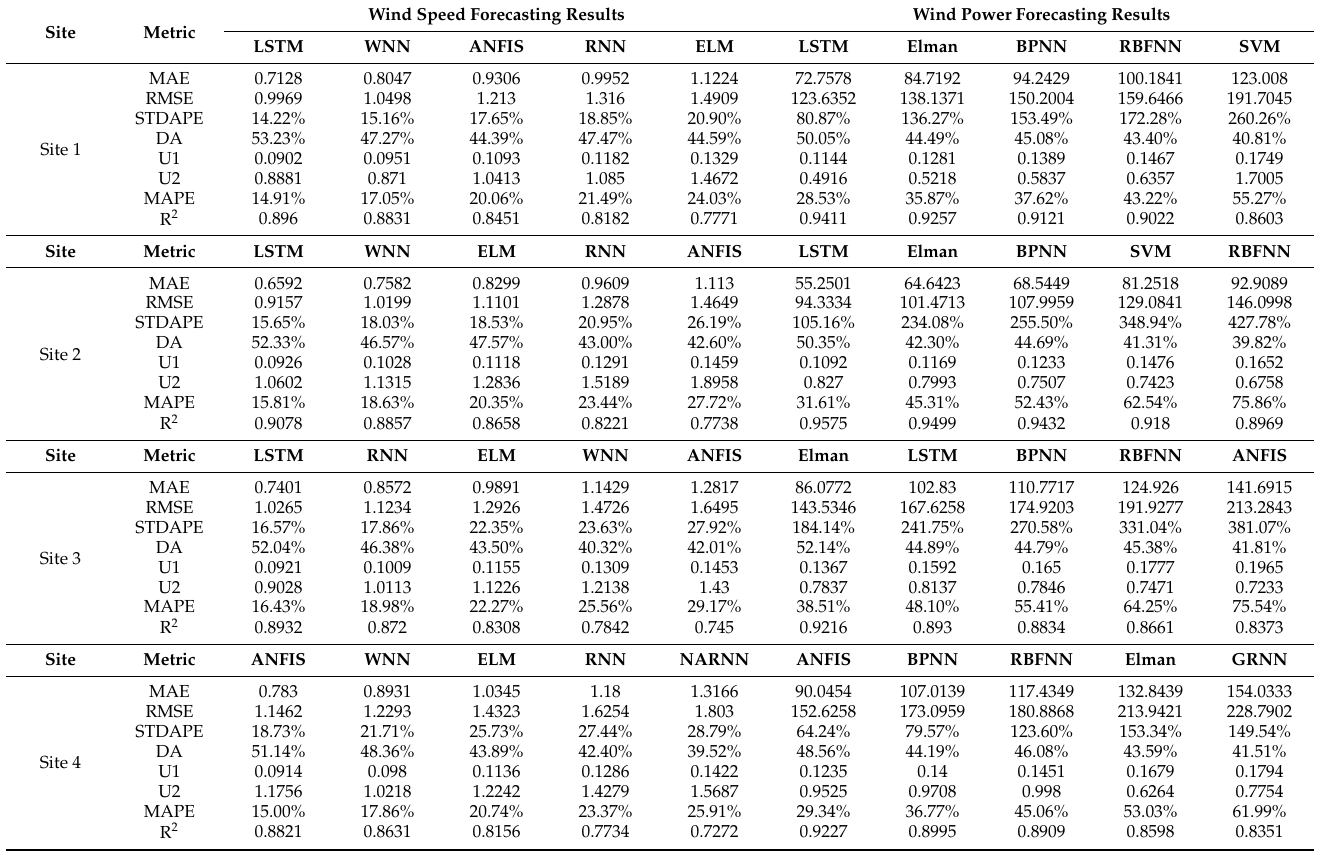
Table A1. The forecasting performance of five optimal sub-models for wind speed and wind power in the first season. Site